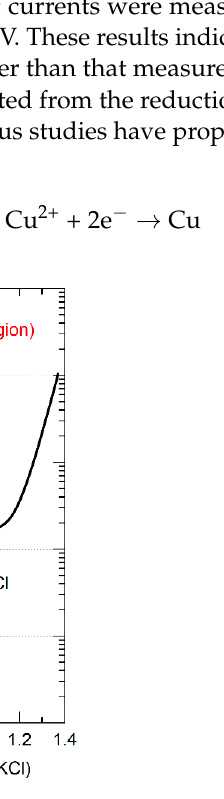
Figure 2. Anodic polarization curves measured in ( a ) 0.1 M NaCl and ( b , c ) 0.1 M NaCl-1 mM CuCl 2 . The potential was scanned from ( a , b ) the cathodic polarization region, and from ( c ) 0.25